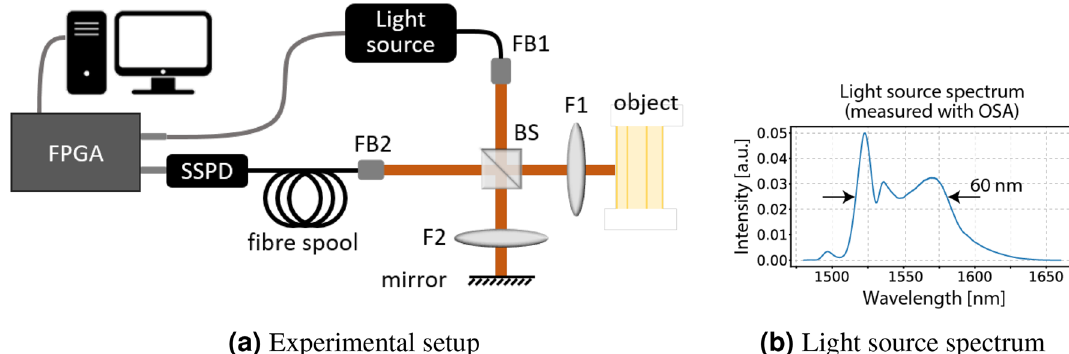
Figure 5. ( a ) Experimental setup (reproduced from Ref. 35 ). The light source is a pulsed laser attenuated